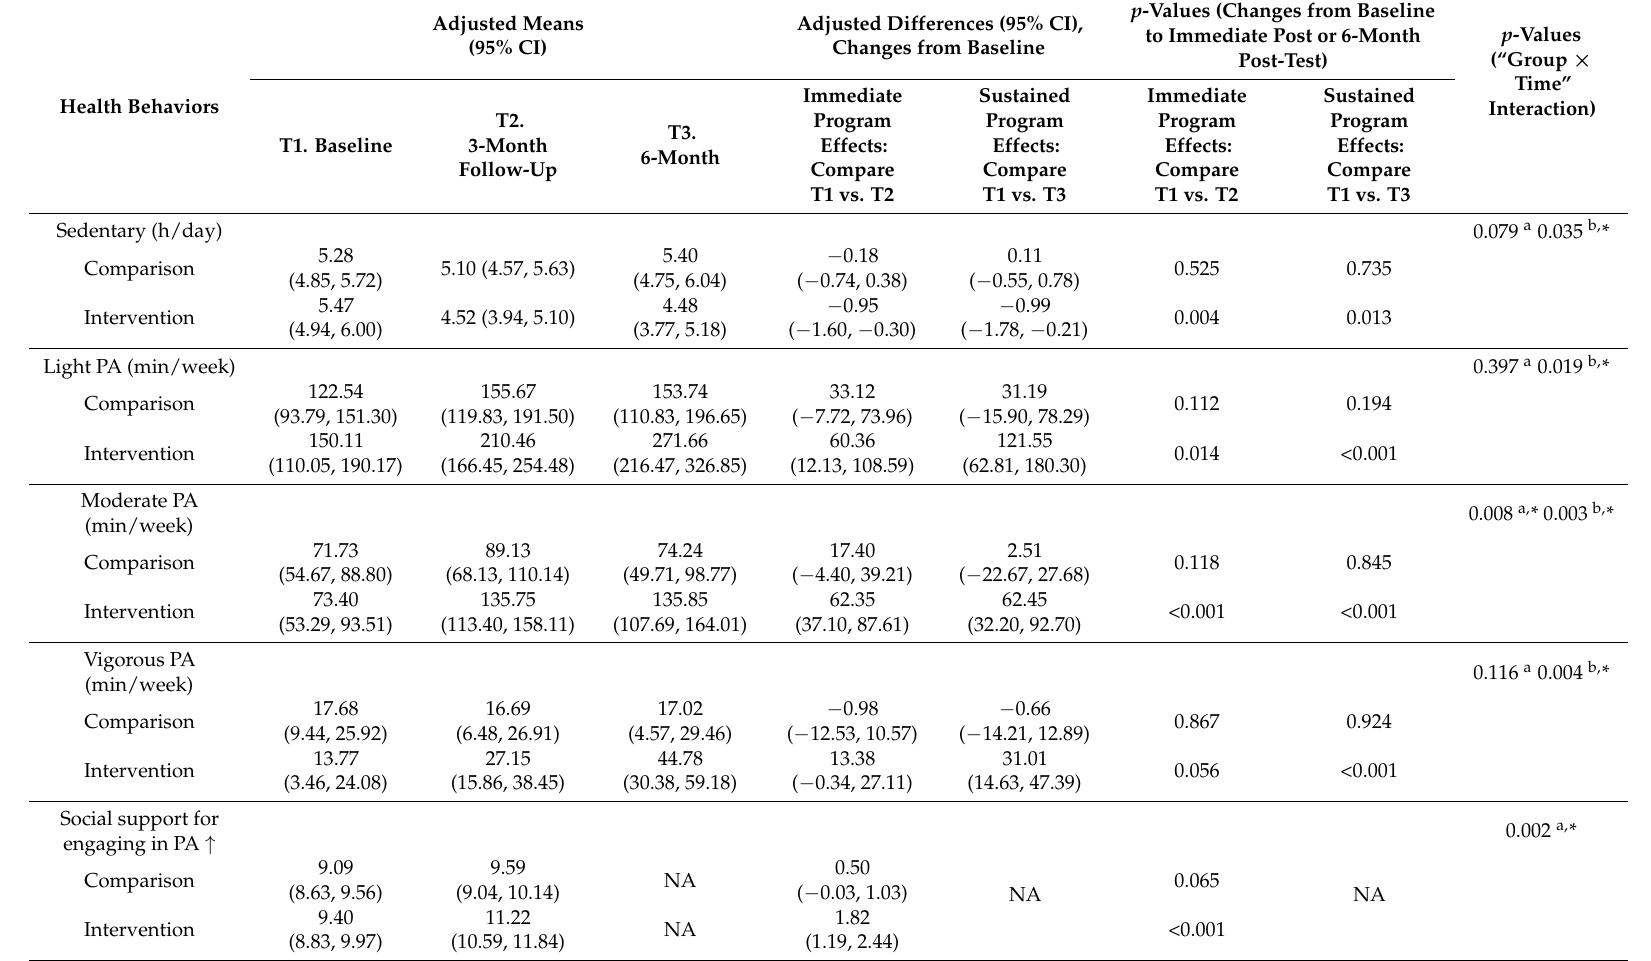
Table 3. Adjusted immediate and sustained program effects on engagement in physical